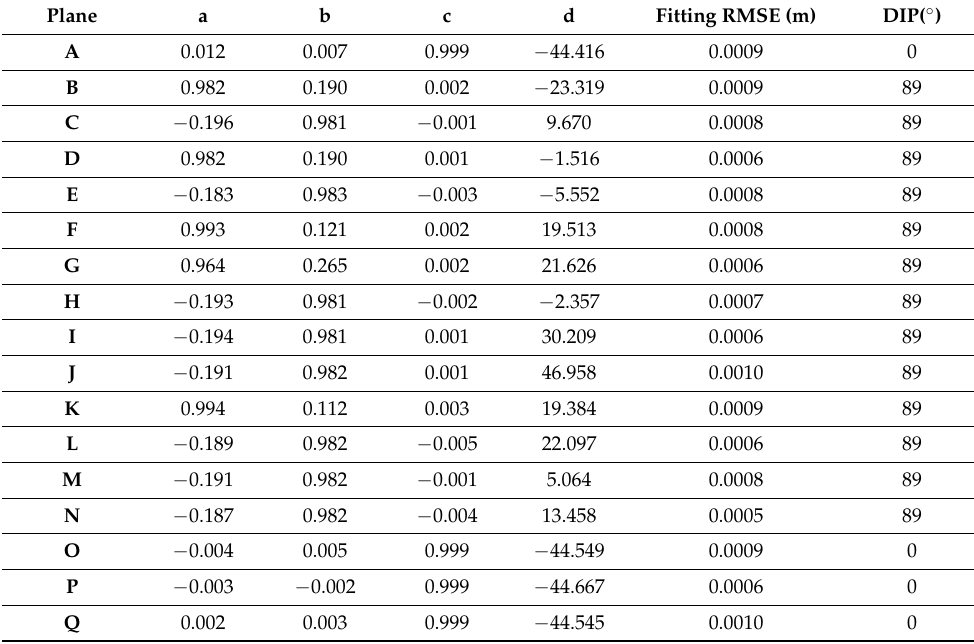
Figure 6. Locations of the selected 17 planes (labeled A to Q) for calibration reference data.